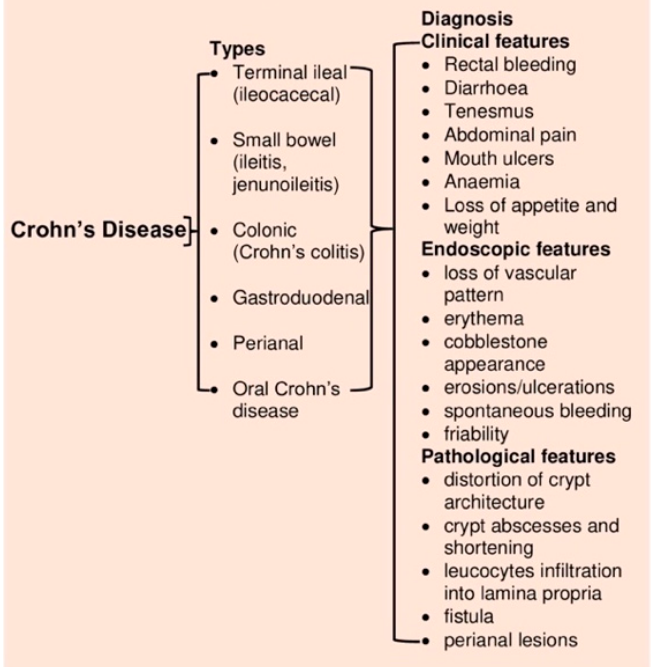
Figure 4. Types of Crohn’s disease and diagnosis.